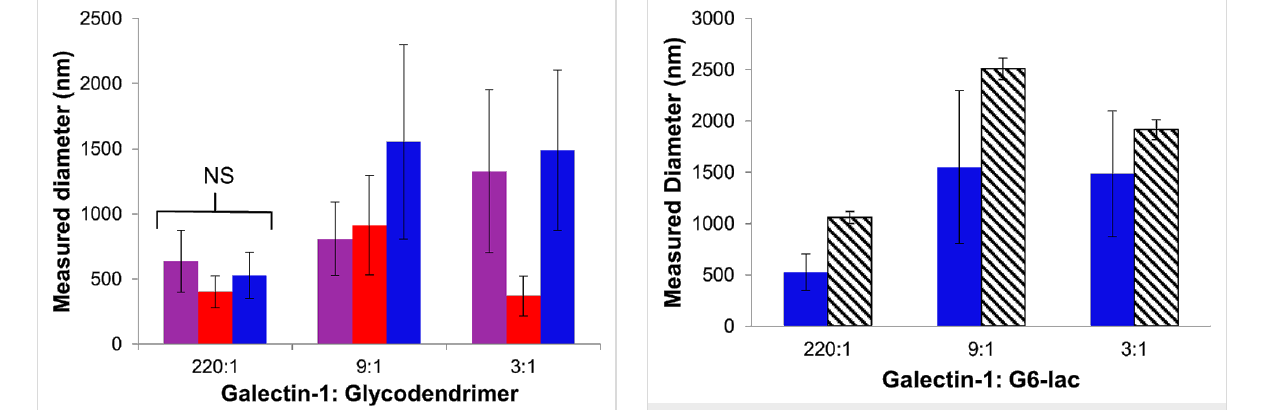
Figure 5: Comparison of average nanoparticle diameter (nm) formed with 4 measured by FM (blue) and DLS (diagonal stripes). co-incubated with galectin-1 and compound 4 . Complete inhibi- tion of aggregation was achieved by monomeric lactose, with an IC 50 of 1.9 mM, indicating that a specific interaction